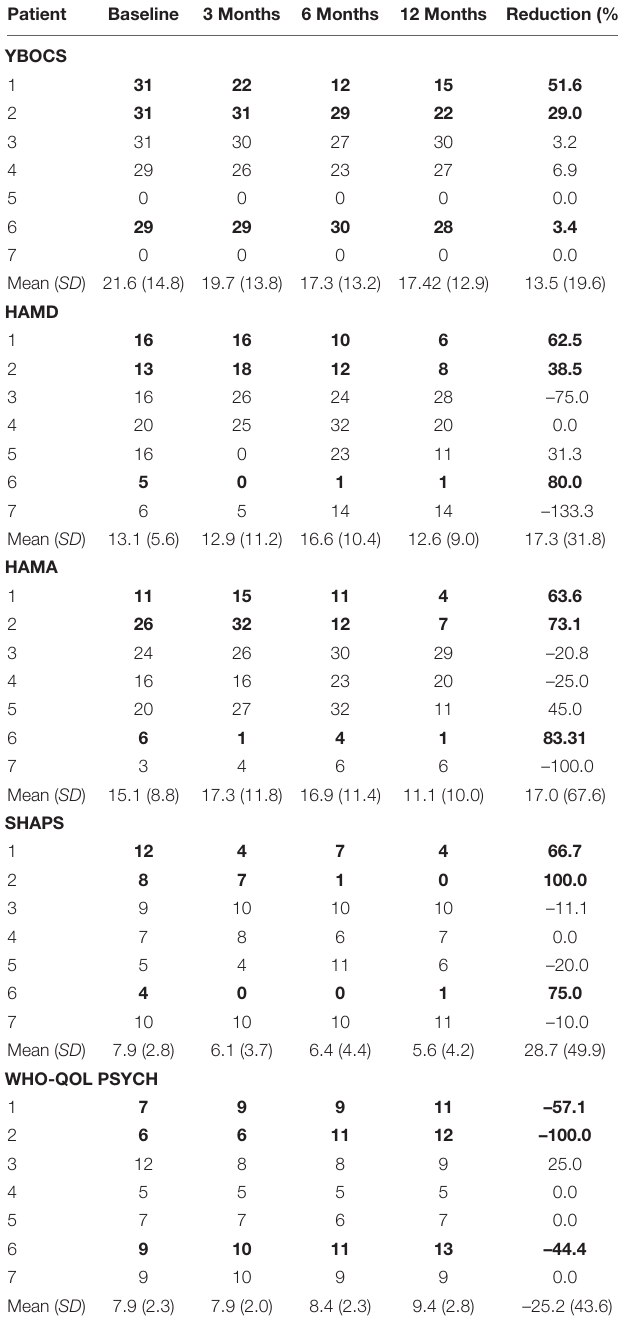
TABLE 4 | Psychometric scores: HAMD, Hamilton Depression Scale; HAMA, Hamilton Anxiety Scale; WHO-QOL-PSYCH, World Health Organization Quality of Life Psychological Subscale; SHAPS, Snaith-Hamilton Pleasure Scale; YBOCS, Yale-Brown Obsessive-Compulsive Scale.